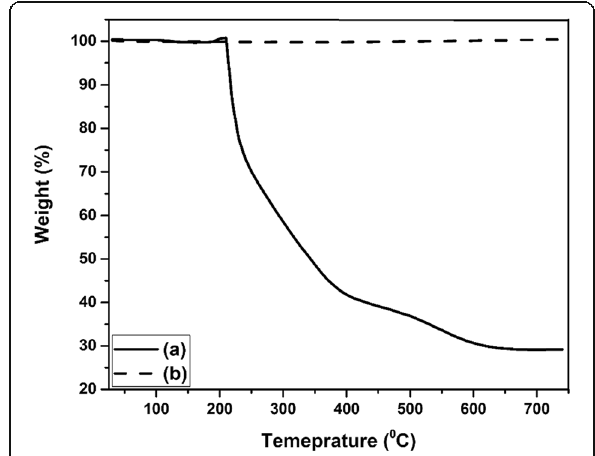
Fig. 5 TG curve of CN-FSNPs ( a ) and bare FSNPs ( b )